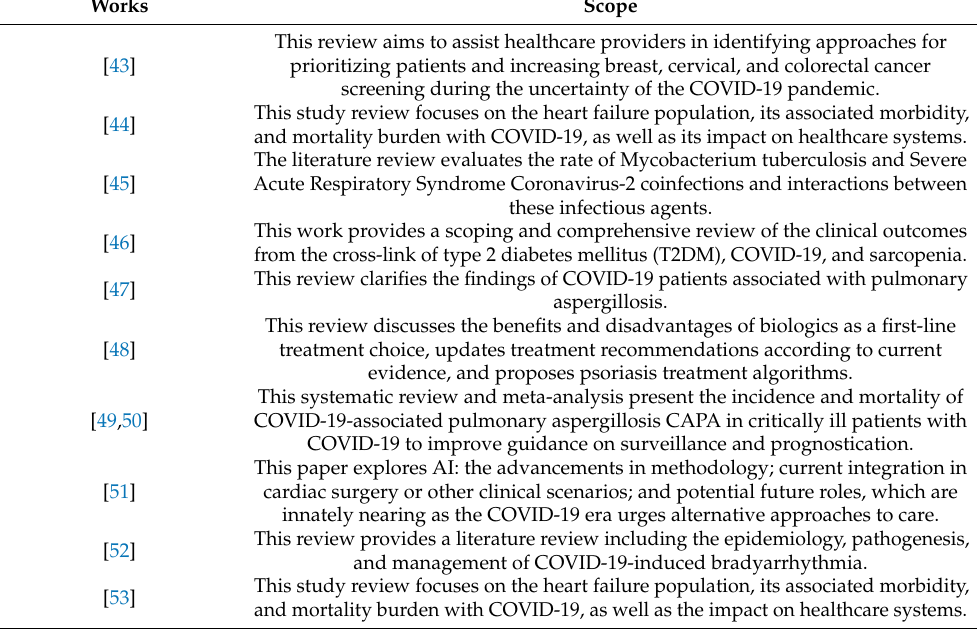
Table 1. Summary of literature review papers that analyzed the relationship of COVID-19 with underlying disease